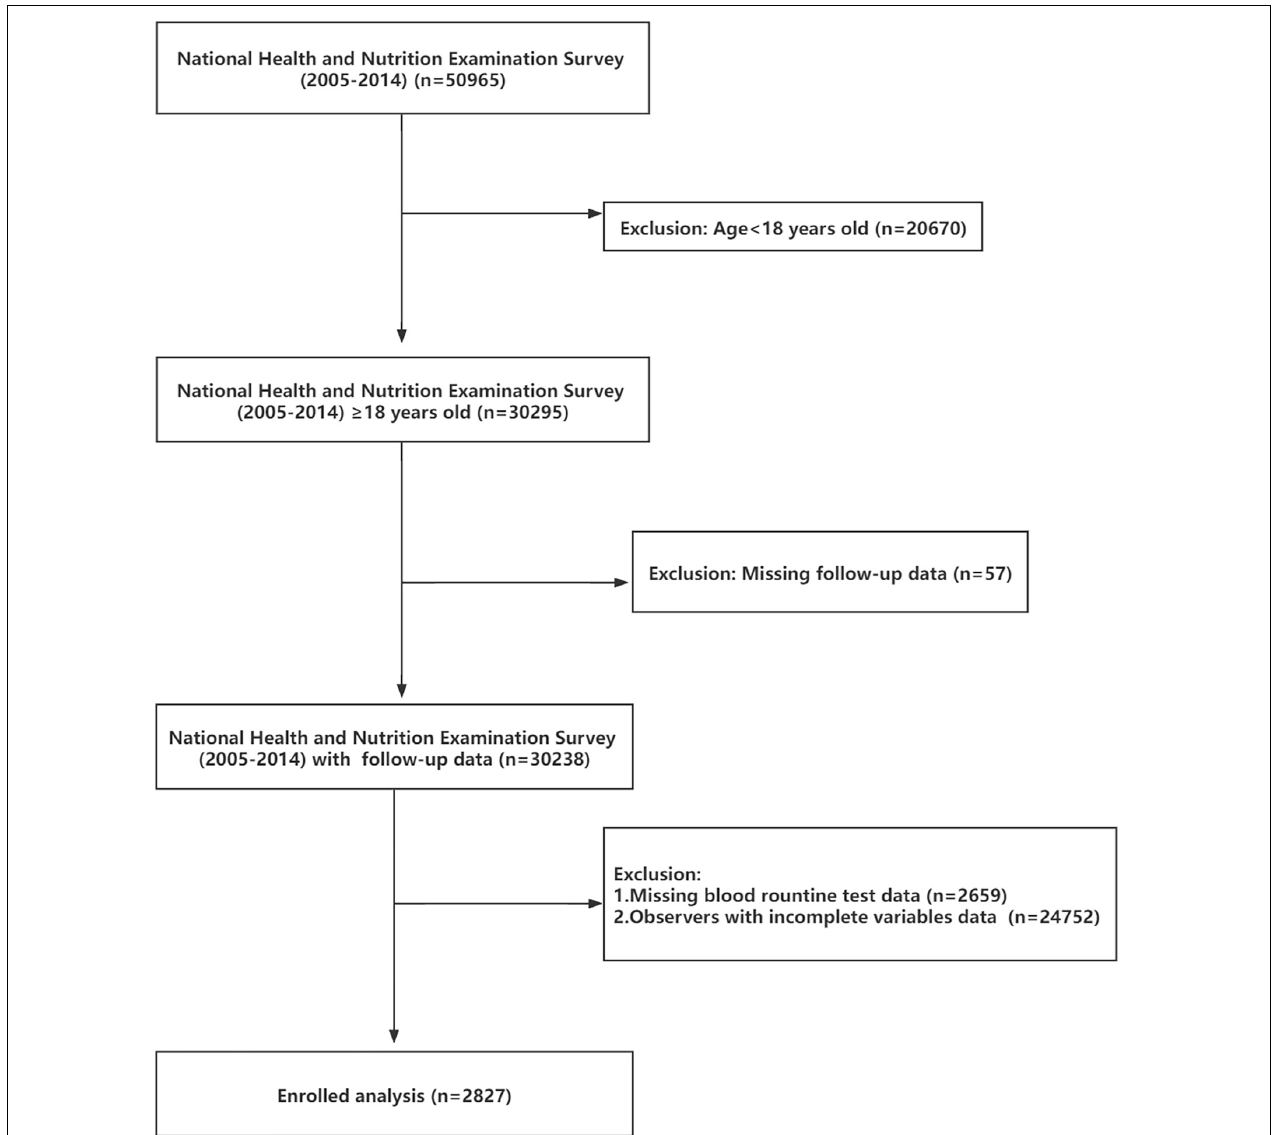
FIGURE 1 | The research